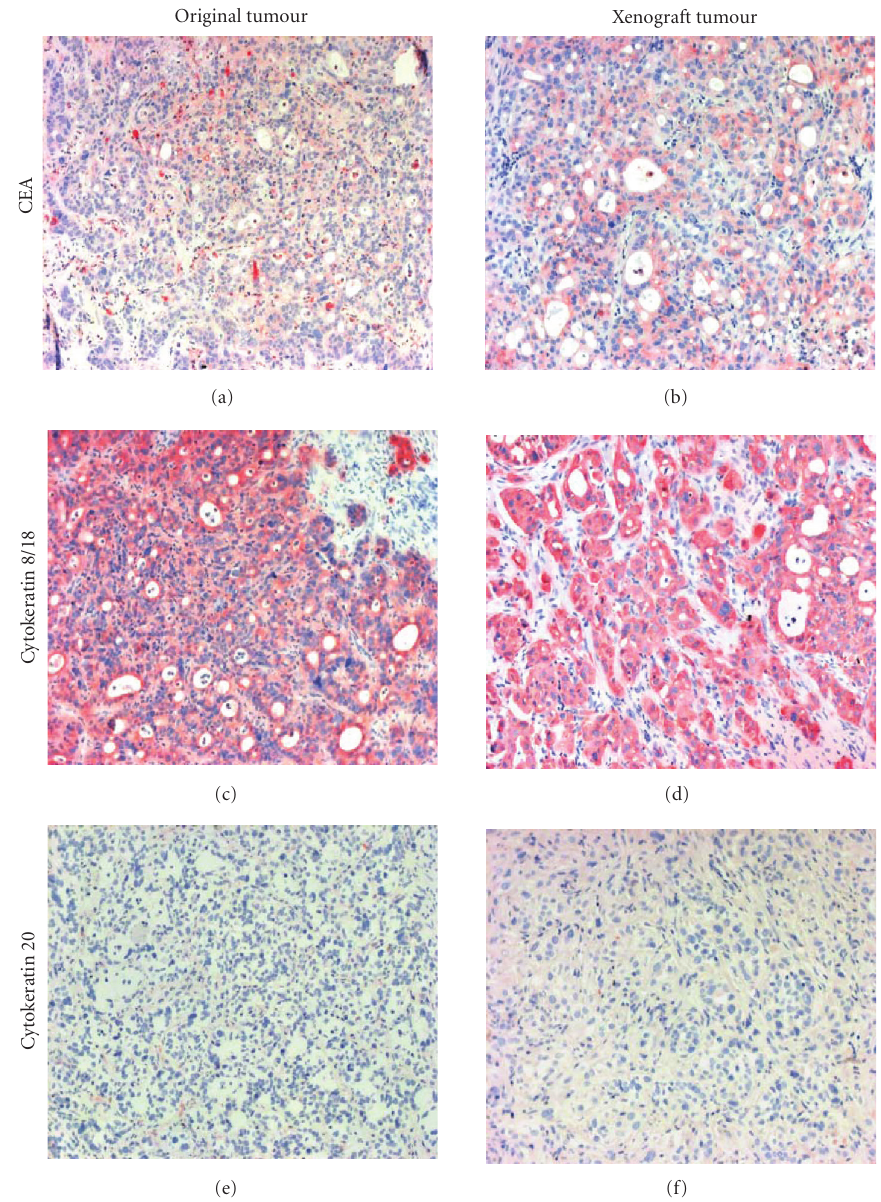
Figure 3: Immunohistochemical analysis of original and corresponding xenograft tumour AKH10. Sections were stained with (a), (b) antibodies specific for CEA, (c), (d) cytokeratin 8/18, and (e), (f) cytokeratin 20. Magnification: